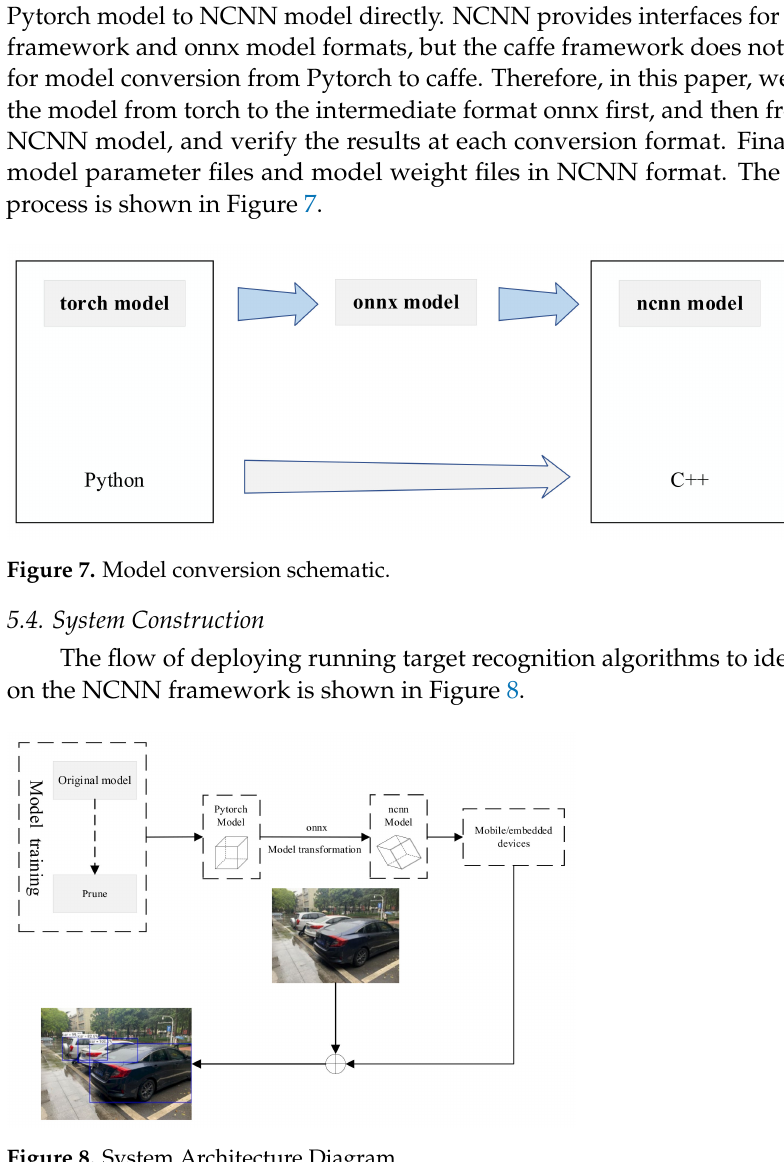
Figure 8. System Architecture